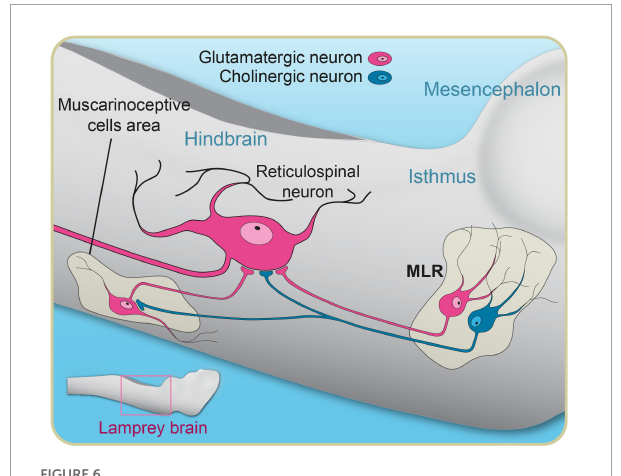
FIGURE6 Schematic illustration of downward projections from the MLR to the pontine reticular formation. In addition to direct projections from glutamatergic and cholinergic MLR neurons to reticulospinal neurons, there is a muscarinic cholinergic projection from the MLR to a group of muscarinoceptive cells in the hindbrain that in turn provide extra excitation to reticulospinal neurons. This pathway is believed to boost the locomotor output at high swimming speeds, acting as a hyperdrive mechanism for locomotion. Adapted from Smetana et al.